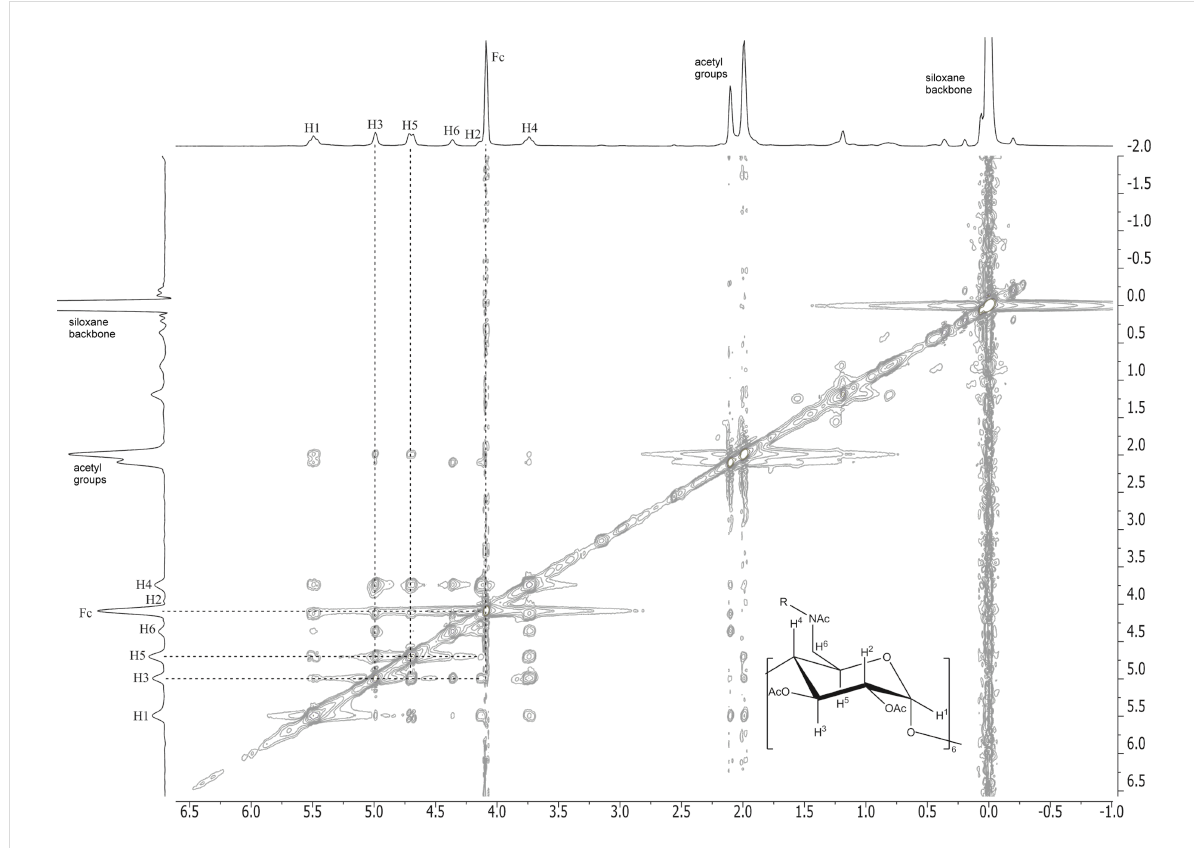
clear shift of the ferrocene signal from 4.22 to 4.19 ppm can be detected, which also suggests that ferrocene molecules are completely complexed by the α -CD